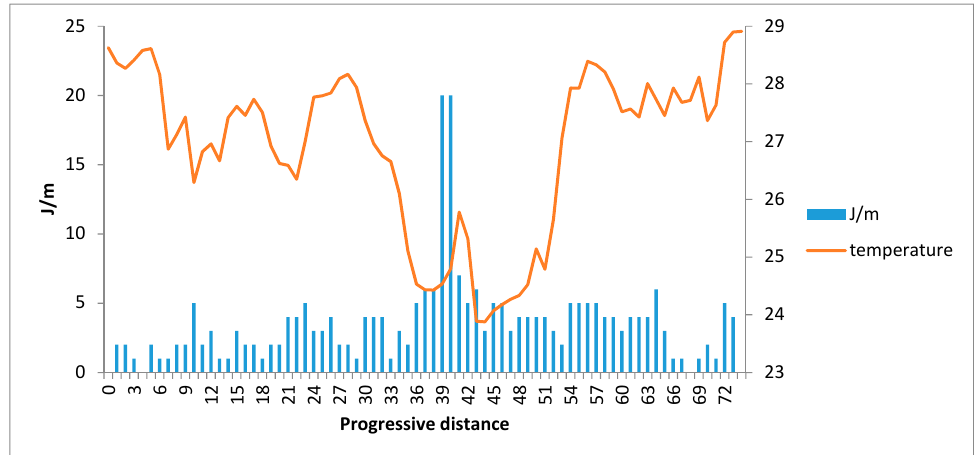
Figure 15. Comparison between the number of joints per meter and the measured temperature for the F19 frame on the SL1 scanline.